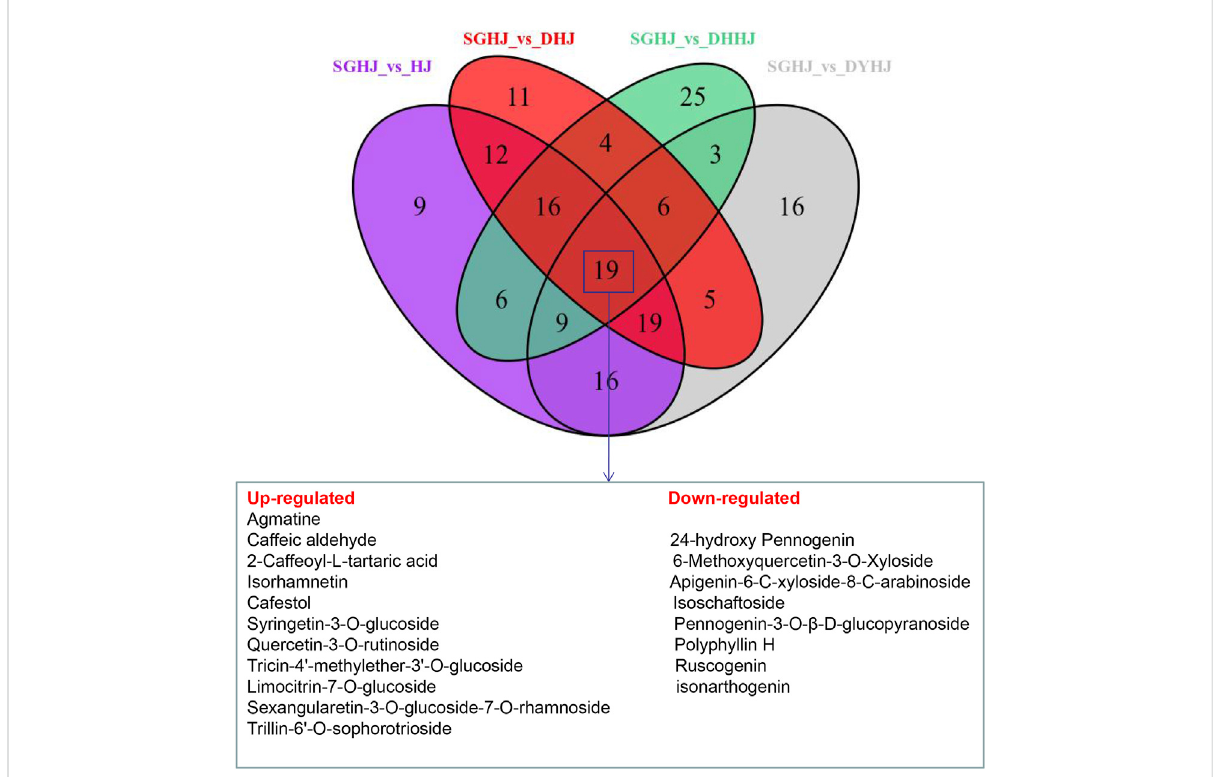
FIGURE 4 Venn diagrams of the number of different metabolites in the comparison of SGHJ versus HJ, SGHJ versus DHJ, SGHJ versus DYHJ, and SGHJ versus DHHJ, respectively. SGHJ: Polygonatum alternicirrhosum Hand.-Mzt. HJ: Polygonatum sibiricum Red. DHJ: Polygonatum kingianum Coll.et Hemsl. DHHJ: Polygonatum cyrtonema